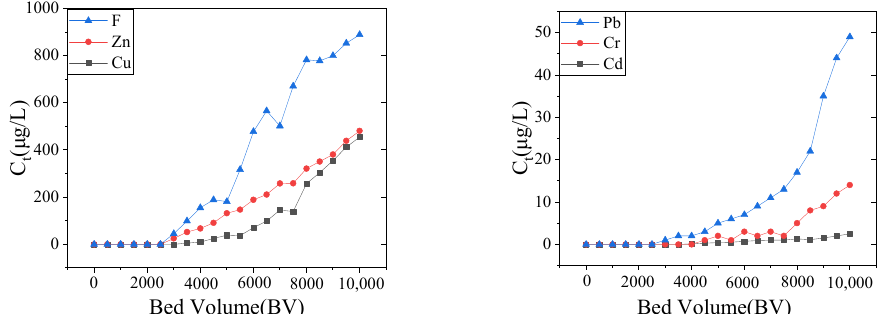
Figure 5. Effect of EBCT on the removal of Cu 2+ , Pb 2+ , Zn 2+ , Cd 2+ , Cr 6+ , and F − . In the column operation, the possible mechanisms responsible for the remediation of metal ions include adsorption in the surface, ion exchange, oxidation, reduction, and precipitation (Figure 6) [18].